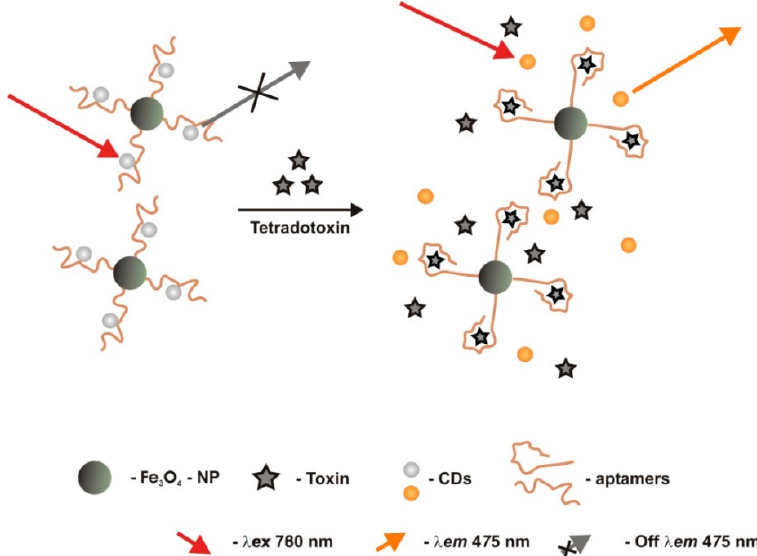
Figure 14. Optical aptasensor designed by Jin et al. [57], combining spectrofluorimetric methods, carbon dots (CDs), and upconversion fluorescence. Magnetic Fe 3 O 4 -nanoparticles (NPs) form Fe 3 O 4 /aptamer complexes, that then self-assembled with the CDs to form Fe 3 O 4 /aptamer/CDs nanocomposites, with upconversion fluorescence properties. When excited at 780 nm, UCF peaks at 475 nm; the fluorescence intensity increasing linearly with increasing tetrodotoxin log concentrations.